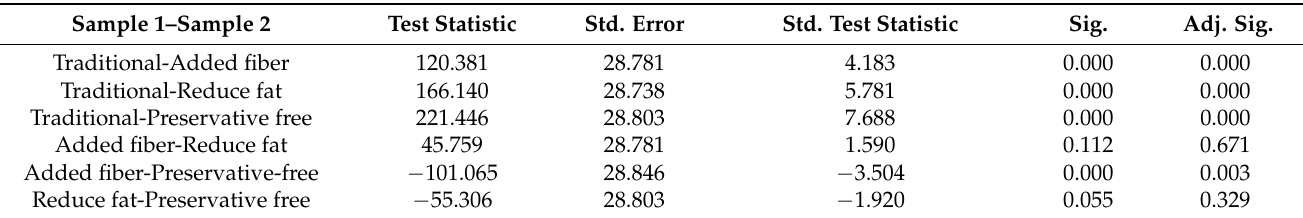
Table 5. Paired comparison test of meatball probability of consumption.